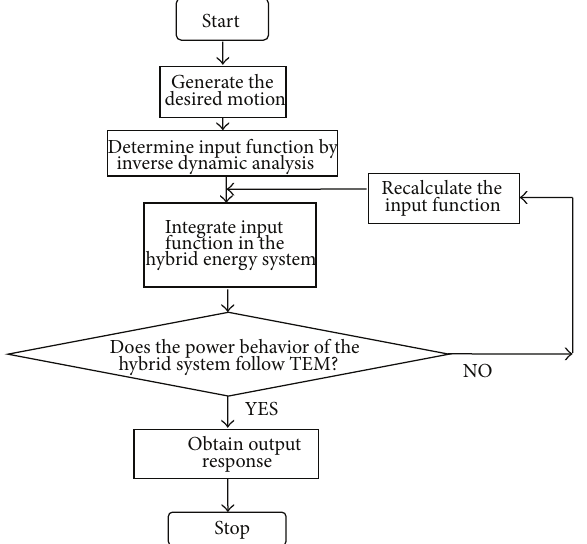
Figure 6: Design process of the inverse dynamic analysis.